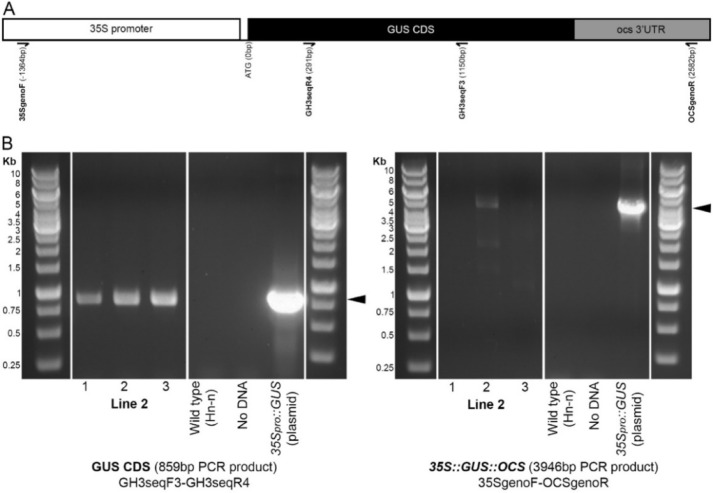
PCR analysis of 35Spro::GUS positive control line identified a full-length 35Spro::GUS insertion.(A) Schematic of the 35Spro::GUS construct marking binding sites of genotyping primers used in (B). All positions shown are relative to the GUS ATG. Primer sequences are listed in the Key Resoucres Table. (B) PCR was performed on genomic DNA extracted from three T1 individuals, including the two investigated by gel blot analysis (Figure 4—figure supplement 2). T-DNA specific reactions were performed to amplify the GUS CDS (left) previously identified by gel blot analysis (Figure 4—figure supplement 2) using the same primers as the gel-blot probe, and a PCR product spanning almost the full length of the 35S::GUS::OCS construct (right). Black arrowheads mark the expected size of the target PCR product in each reaction. PCR results indicate the presence of a full length 35Spro::GUS T-DNA in this line.